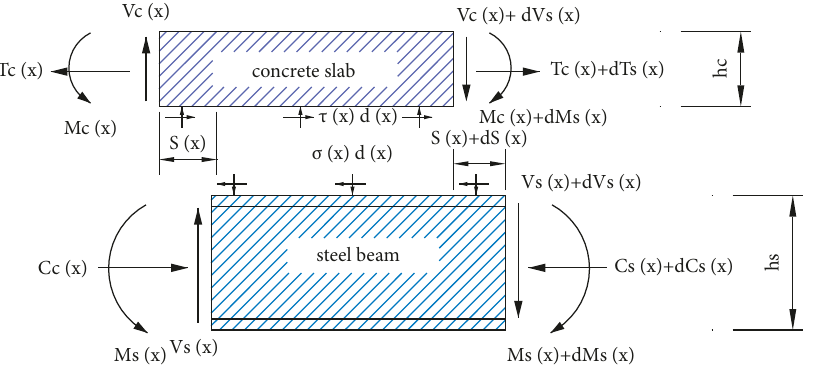
Figure 2: Internal force distribution in a microsegment of the